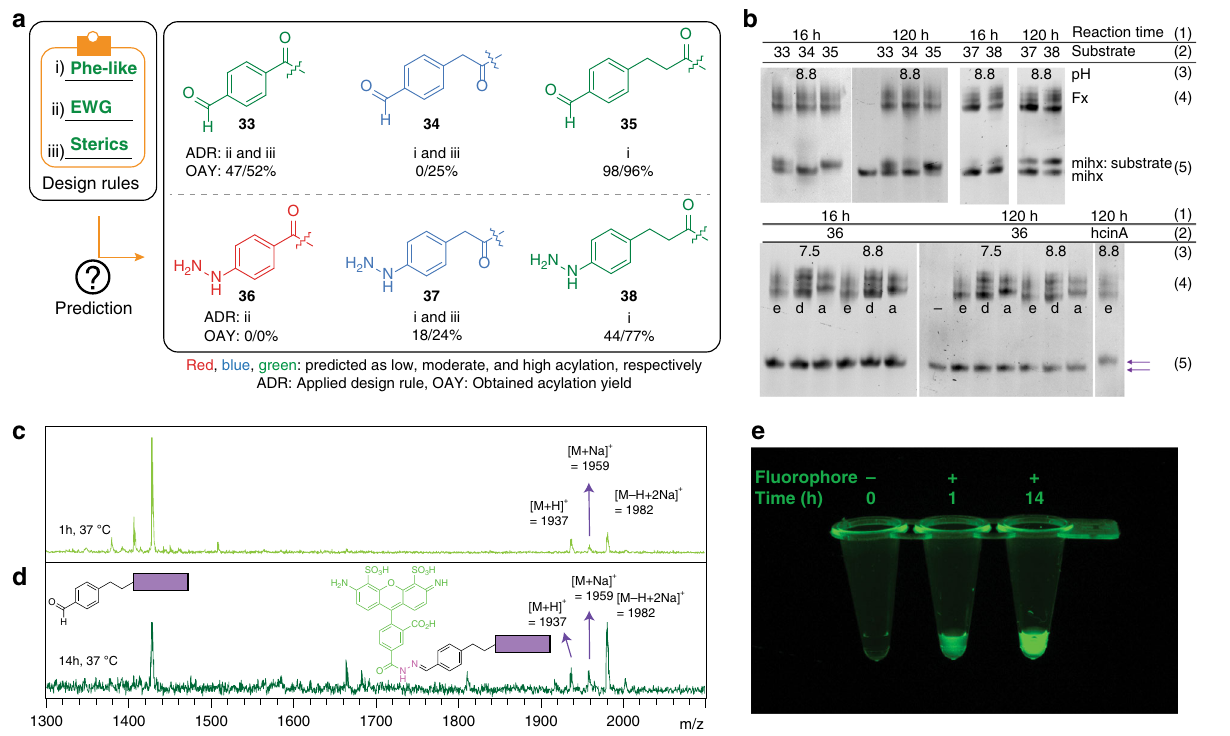
Fig. 6 Putting fl exizyme design rules into action for aldehyde and hydrazine bioconjugation. a We designed and synthesized 6 additional substrates ( 33 – 36 ). Before Fx-mediated acylation, we estimated acylation of the substrates would give a low (<20 %, red), moderate (20 – 50%, blue), and high (>50%, green) yield. b 33 – 35 and 37 – 38 were charged to mihx with the predicted acylation yields (upper panel). In contrast, 36 containing an electron- donating group was not charged to mihx at any pHs, reaction times, and fl exizymes, whereas hydrocinnamic acid ( B ) was charged in 100% yield (lower panel), suggesting our design rules are in a good agreement with our prediction and useful as an ef fi cient tool for predicting a substrate tRNA-charging yield. The obtained acylation yields (OAY, Fig. 6a) were determined by quantifying the relative band intensity on the gel using ImageJ software. c , d Mass spectra of the 35 peptides incubated with a hydrazide dye (Alex Fluor 488) at 37 °C for 1 and 14 h, respectively. The peaks correspond to the peptide with the dye chemically attached to 35 . e The puri fi ed products obtained from the PURExpress reaction at the time point of 1 h and 14 h showed fl uorescence after exposure of UV light fi ltered by